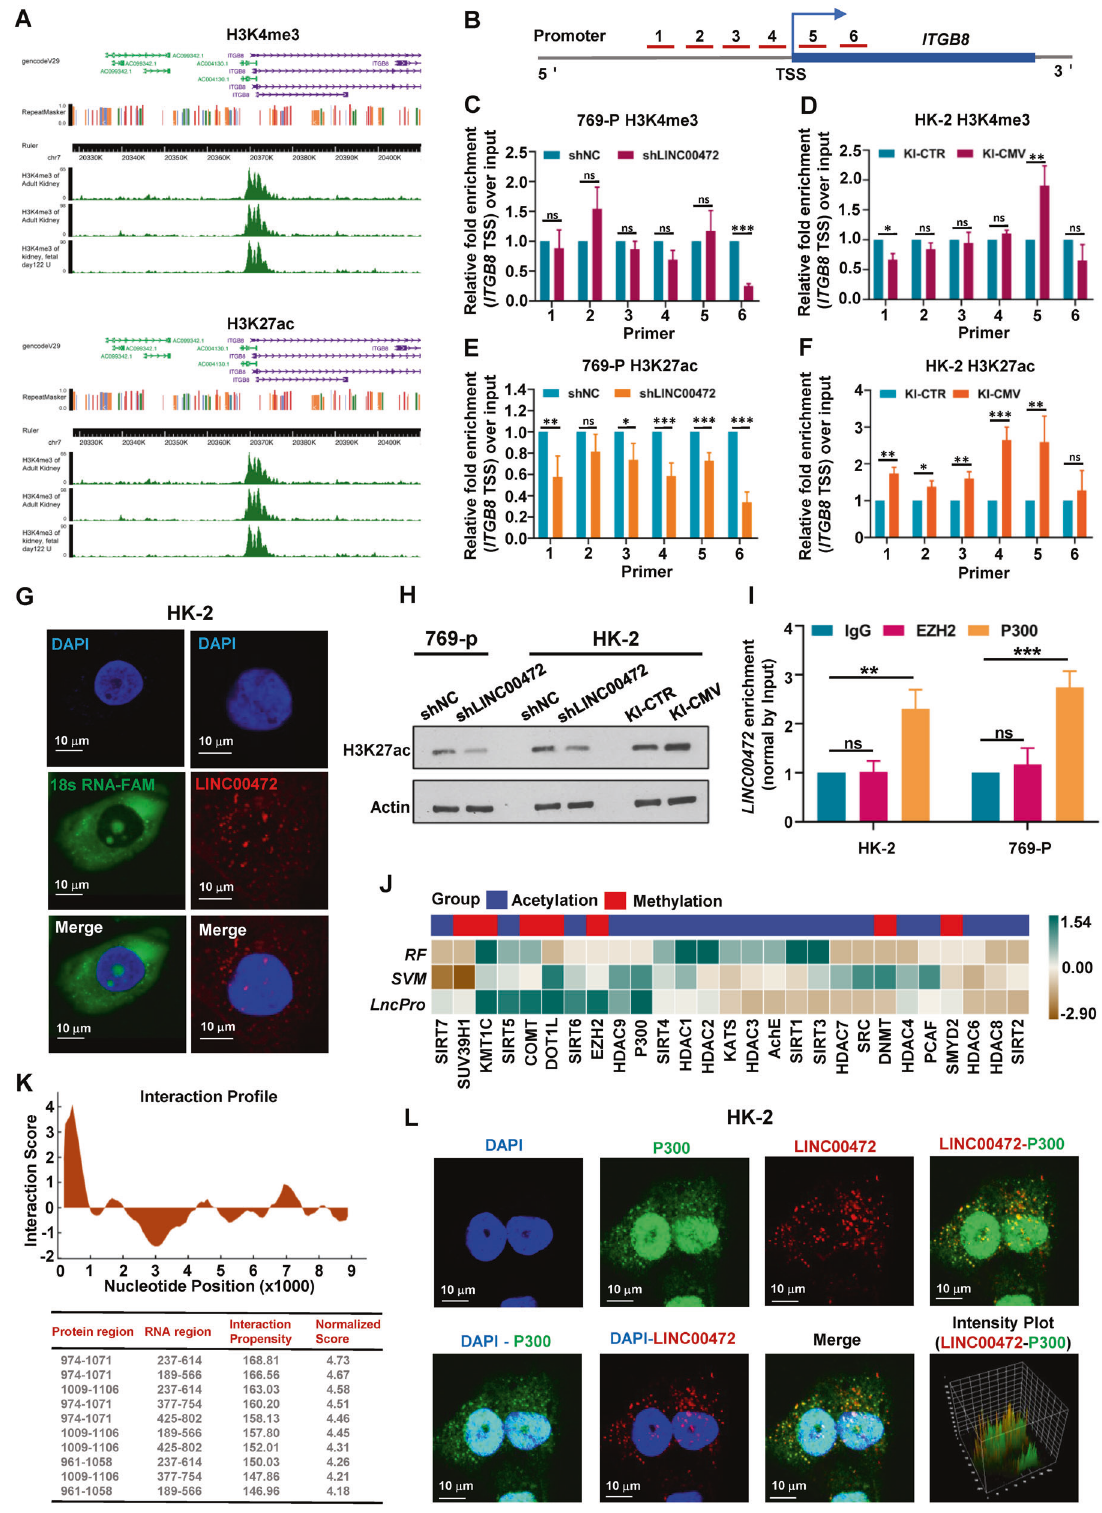
ITGB8 is a potential target gene regulated by LINC00472 We analyzed the RNA sequencing data of HK-2 KO-NC/KO-PE and HK-2 KI-NC/KI-CMV, and found 317 genes with the same expression level trend (Fig. 7A). Through PPI interaction analysis of the 317 genes in STRING database, we found a sub